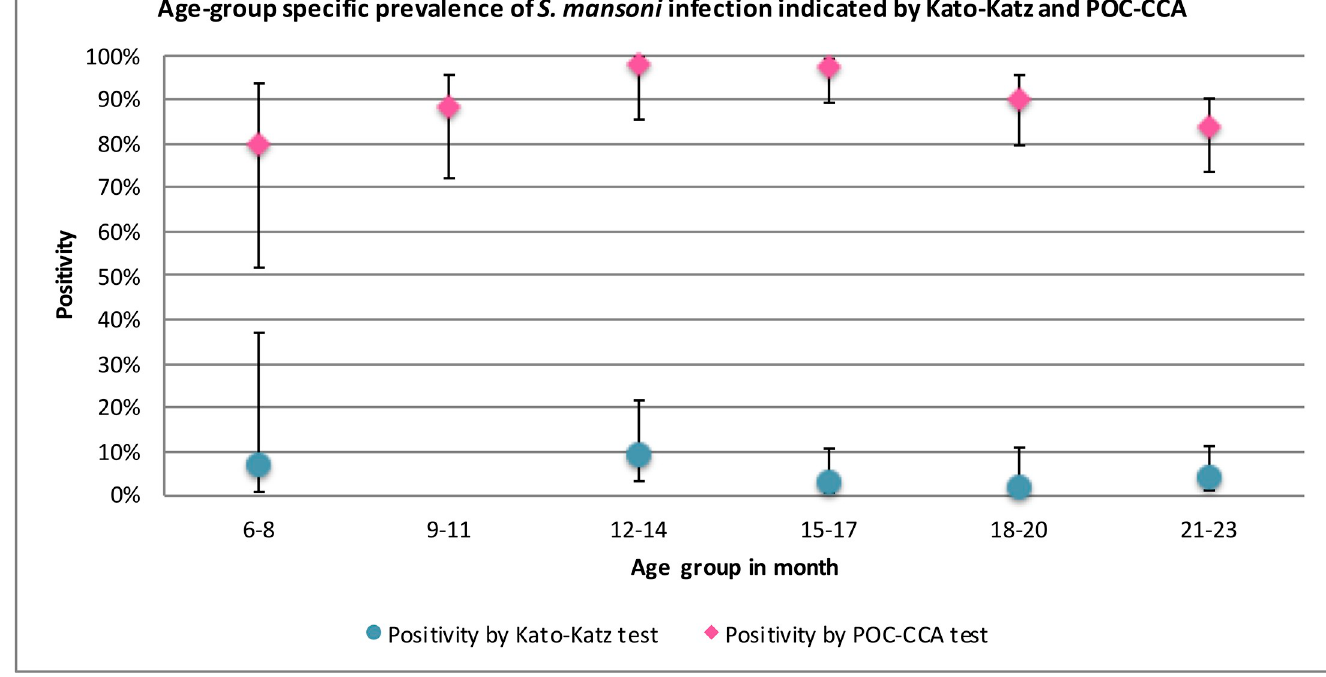
Fig 4. Age-group specific prevalence of S . mansoni infection determined by Kato-Katz and POC-CCA test.